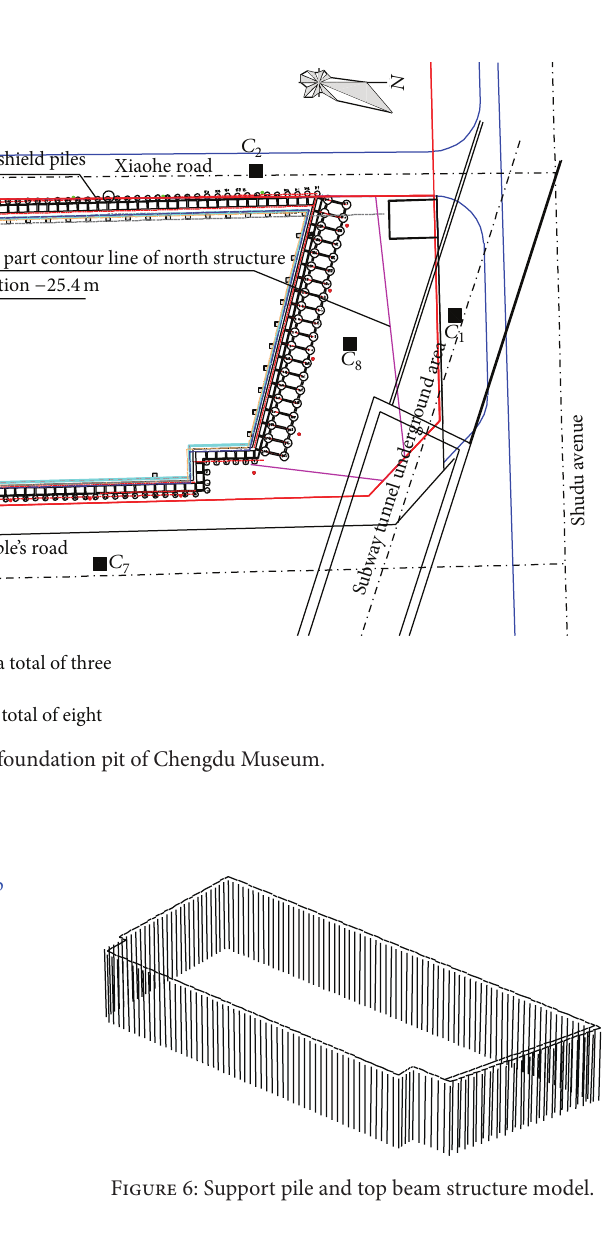
Figure 5: Numerical model after static calculation.